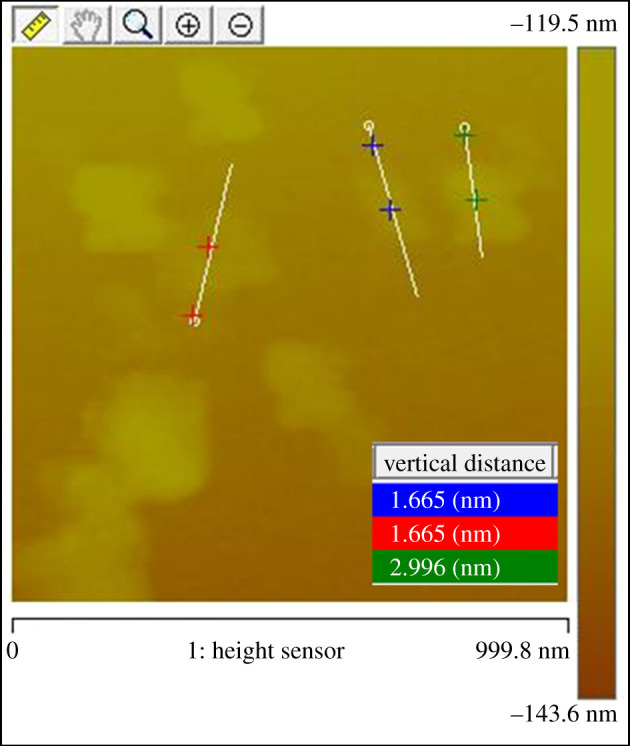
AFM image of exfoliated BP layers deposited on SiO2/Si by spin coating process.